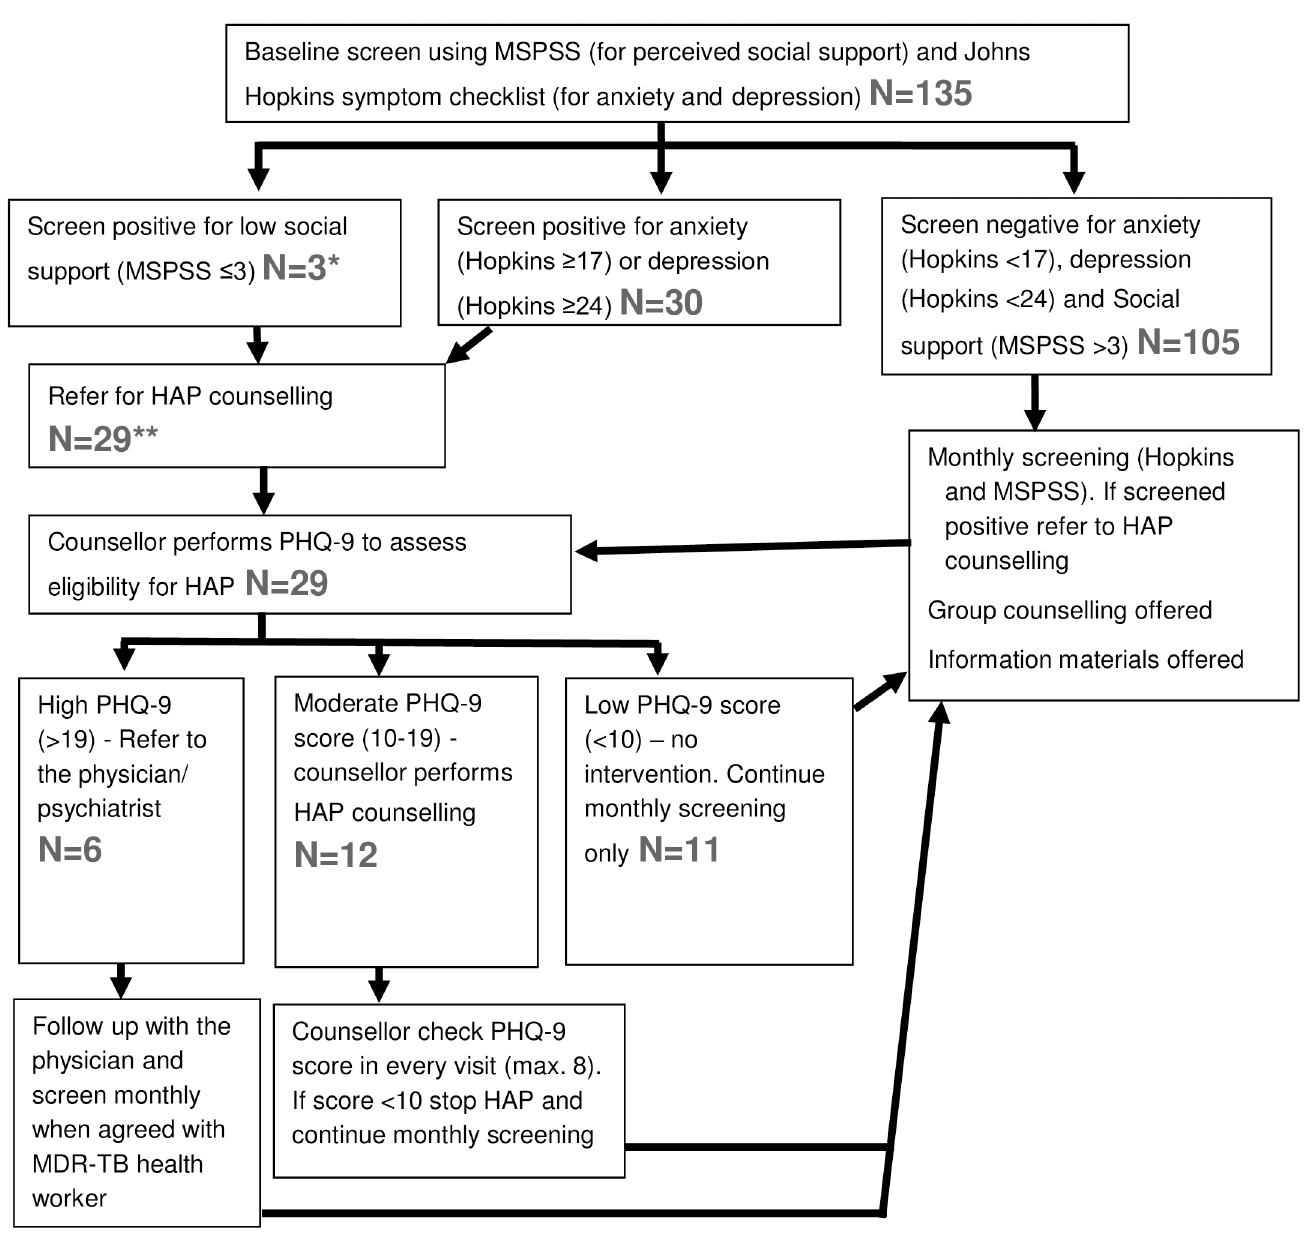
Fig 1. Flow diagram of the screening process in this study. (cid:3) These 3 patients with MSPSS < 3 also screened positive for depression or anxiety on the Hopkins tool. (cid:3)(cid:3) 1 patient with a high Hopkins score was (mistakenly) not referred to the counsellor and so not counted here.